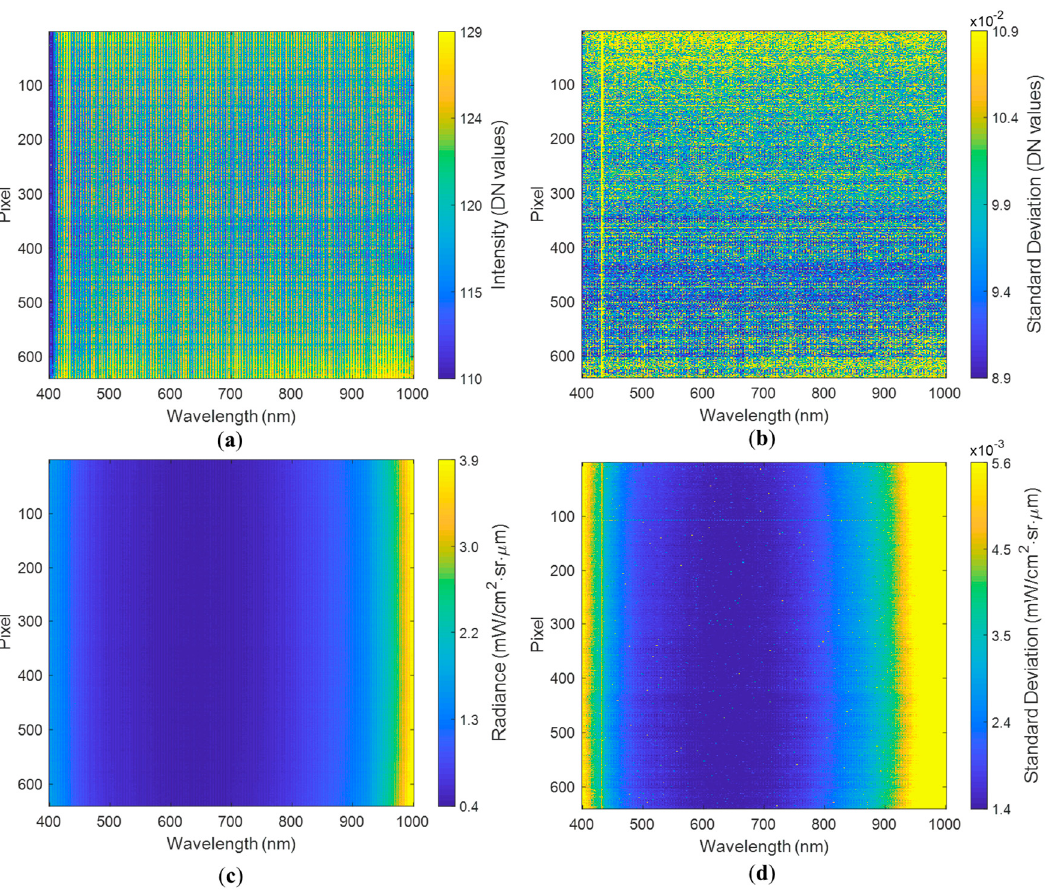
Figure 2. Spectral signature for the dark current (covered lens) experiment with an exposure of 6 ms, showing ( a ) DN mean spectral signature, ( b ) standard deviation of the DN spectral signature, ( c ) radiance mean spectral signature, and ( d ) standard deviation of the radiance spectral signature.